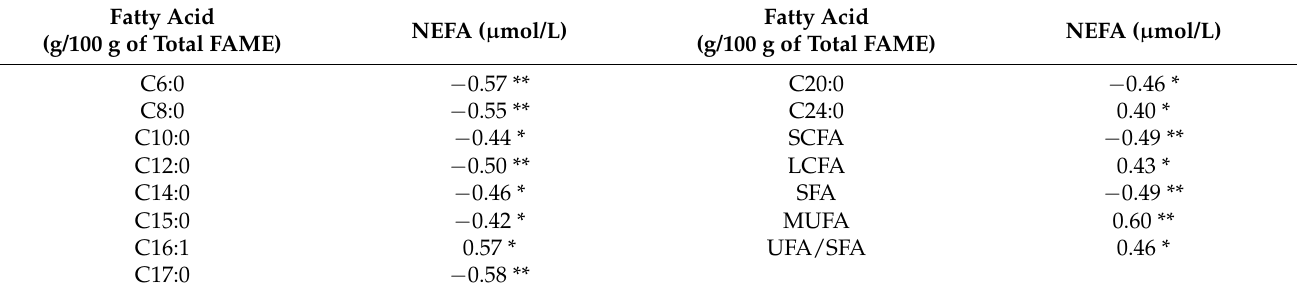
Table 6. Correlations between blood Not Esterified Fatty Acids (NEFAs) and milk fatty acid profile (only statistically significant correlations are